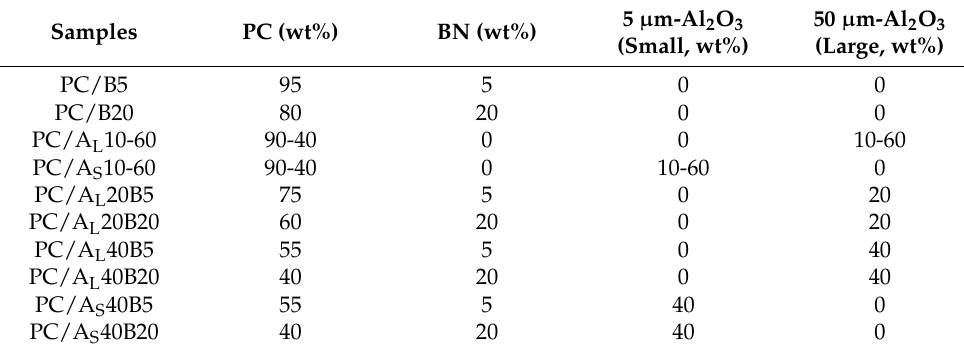
Table 1. Formulation of PC/Al 2 O 3 /BN